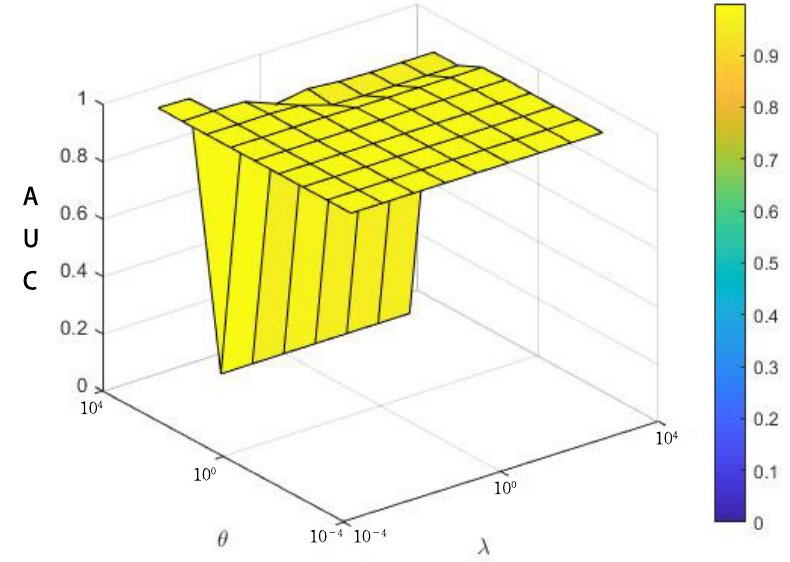
Figure 10. Tuning λ and θ of the proposed LRSNCR in the ABU-urban dataset.